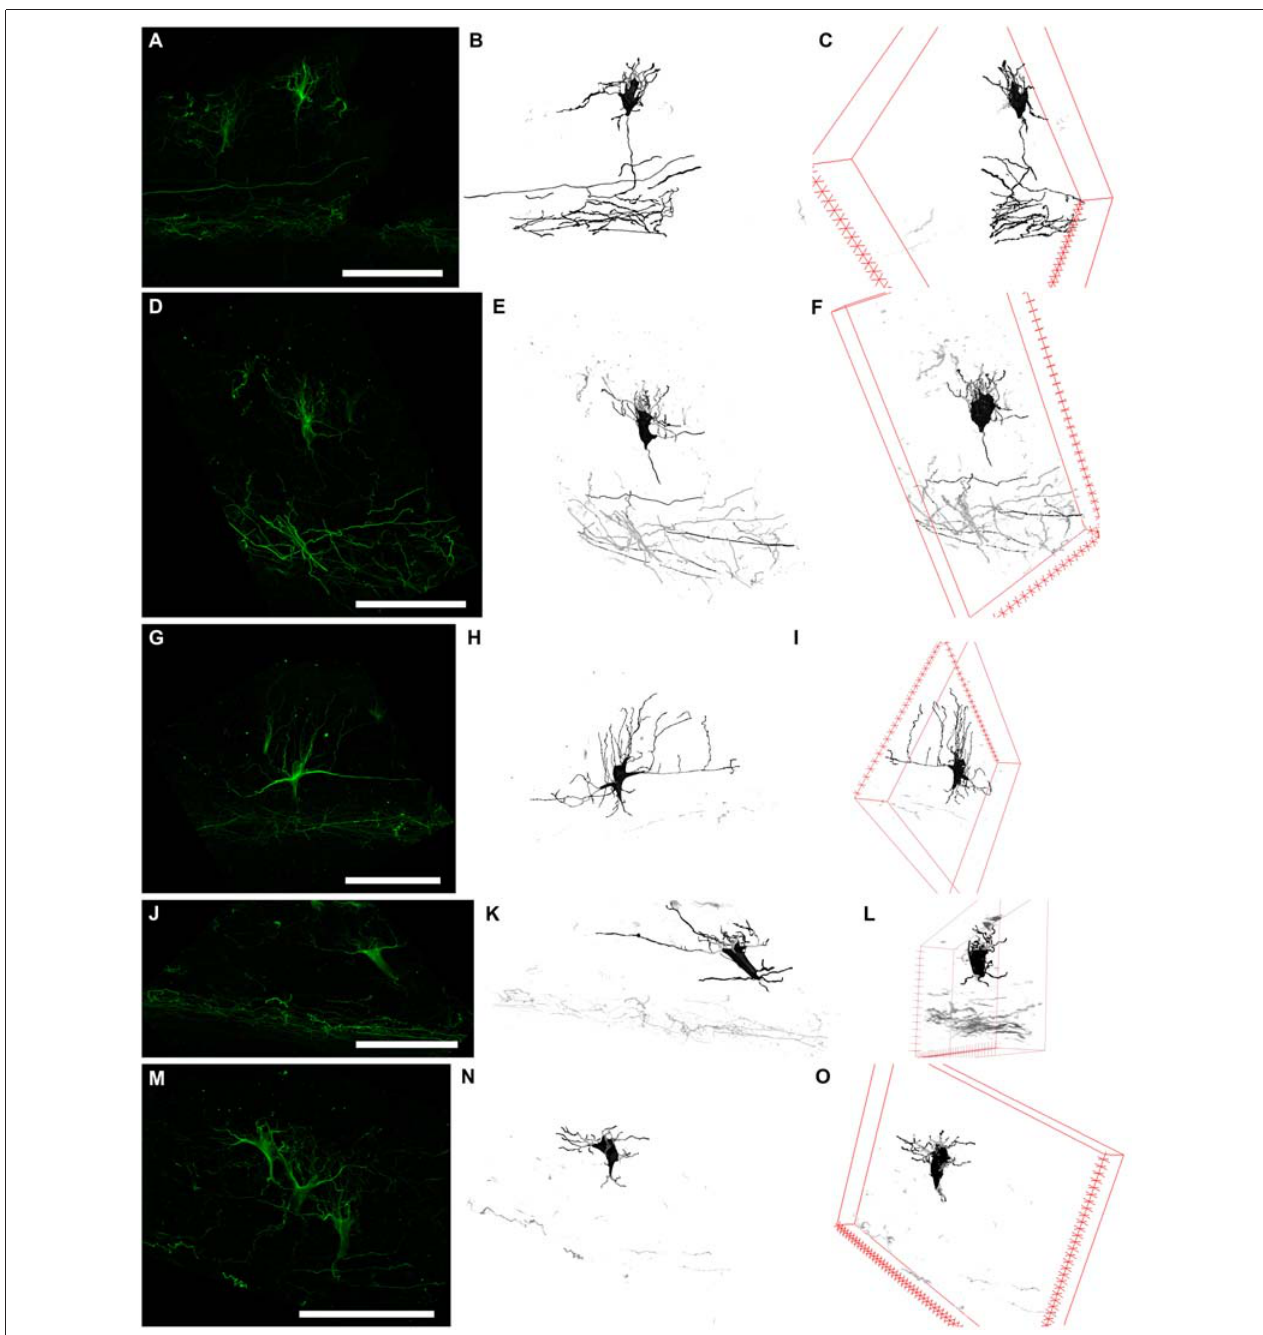
FIGURE 5 | Three types of N200-positive cells . Left column (A,D,G,J,M) N200-positive C–R cells. Middle column (B,E,H,K,N) —C–R cells reconstructed from a confocal stack with a Simple Neurite Tracer. Right column (C,F,I,L,O) rotation of the cell in the x plane. (A–C) and (D–F) the first type of C–R cells, (G–I) —the second type, (J–L) and (M–O) —the third type. Scale bars: (A,D,G,J,M) 100 µ m.